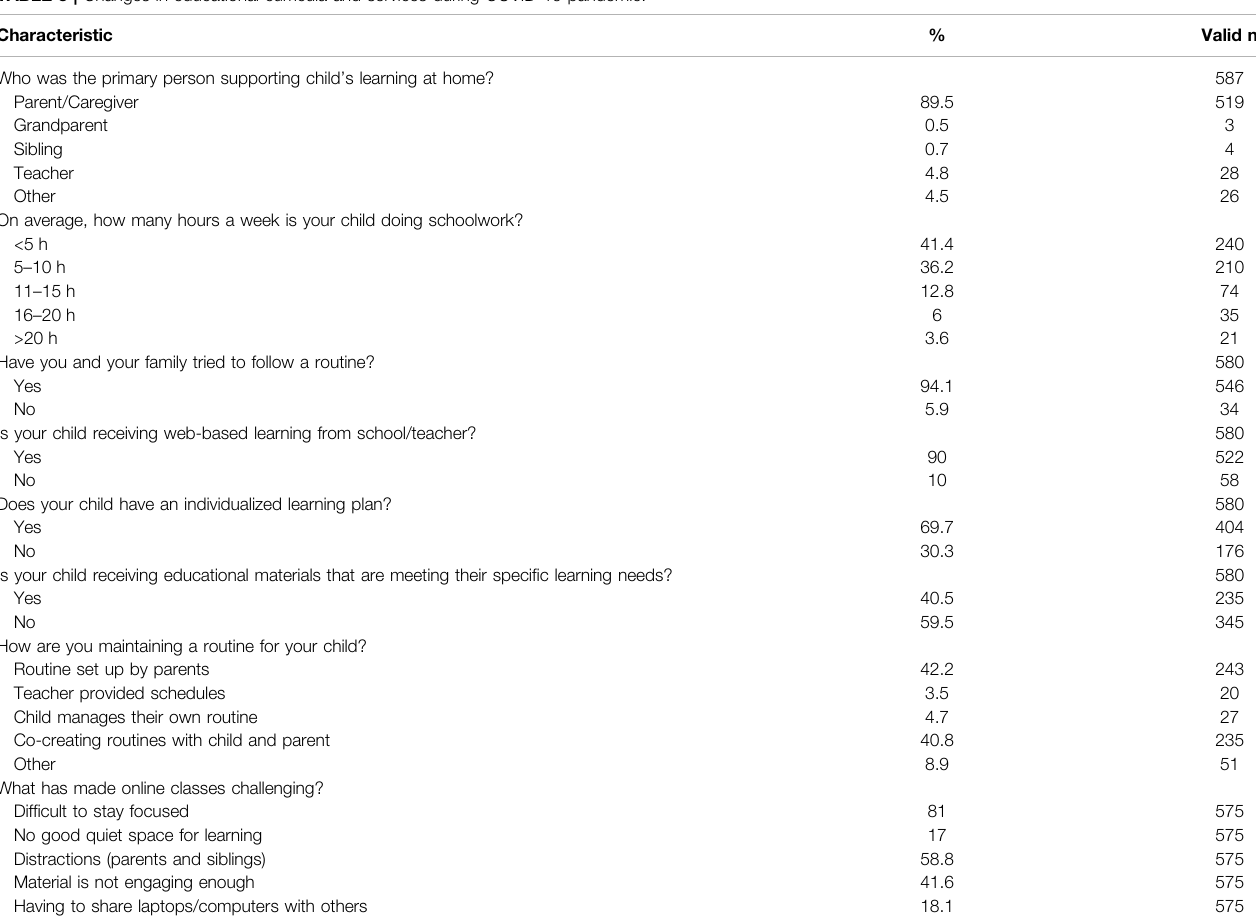
TABLE 3 | Changes in educational curricula and services during COVID-19 pandemic. Characteristic